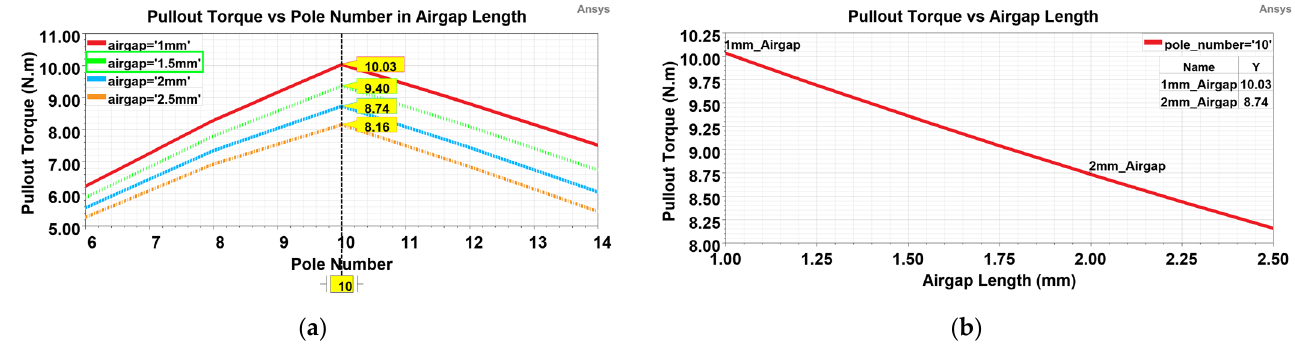
Figure 9. Pullout torque investigation versus: ( a ) Pole number in air gap length; ( b ) Air gap length.